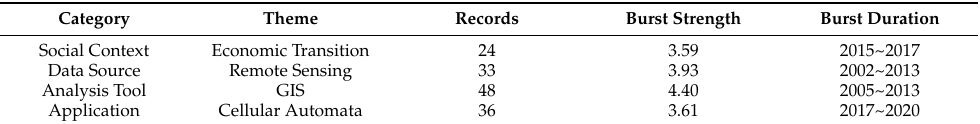
Table 2. Results of burst